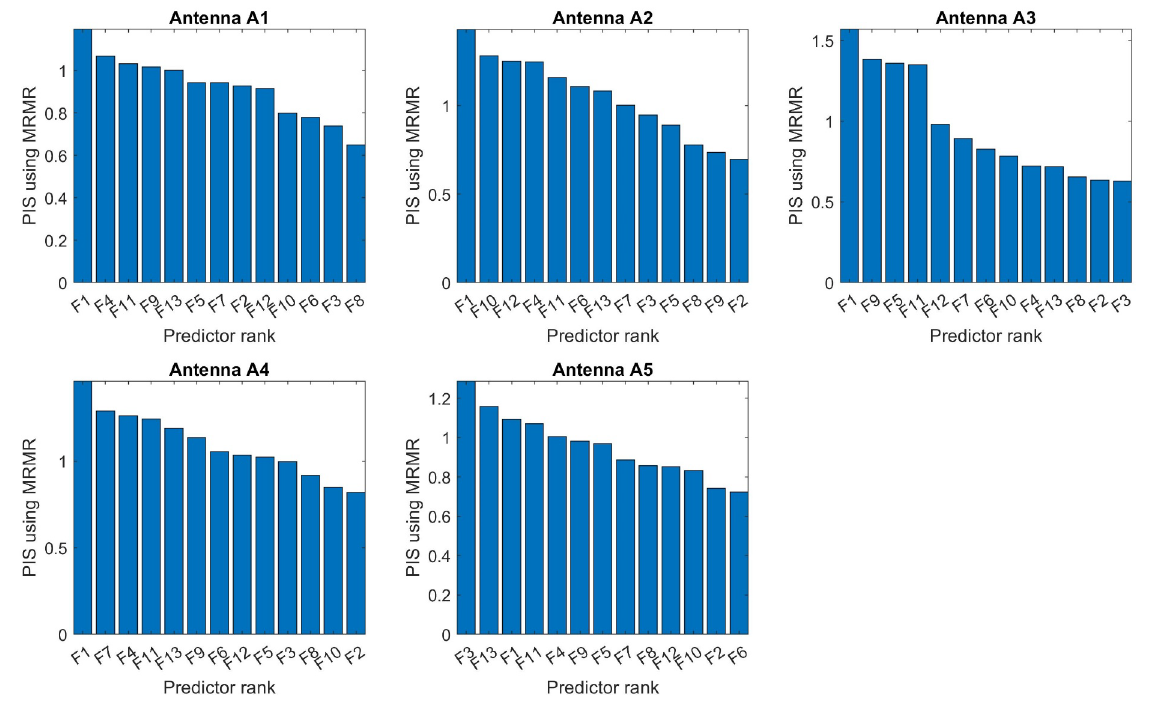
Figure 9. PIS values calculated using the MRMR algorithm for the five considered antenna.